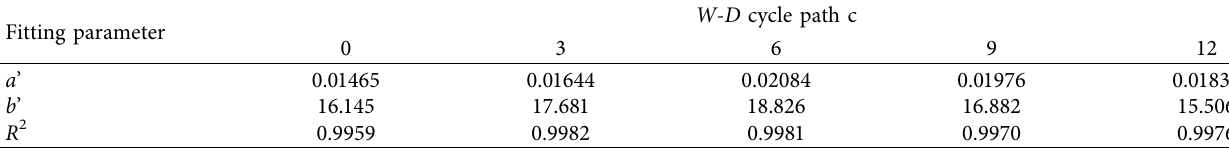
Table 6: Fitting parameters of G